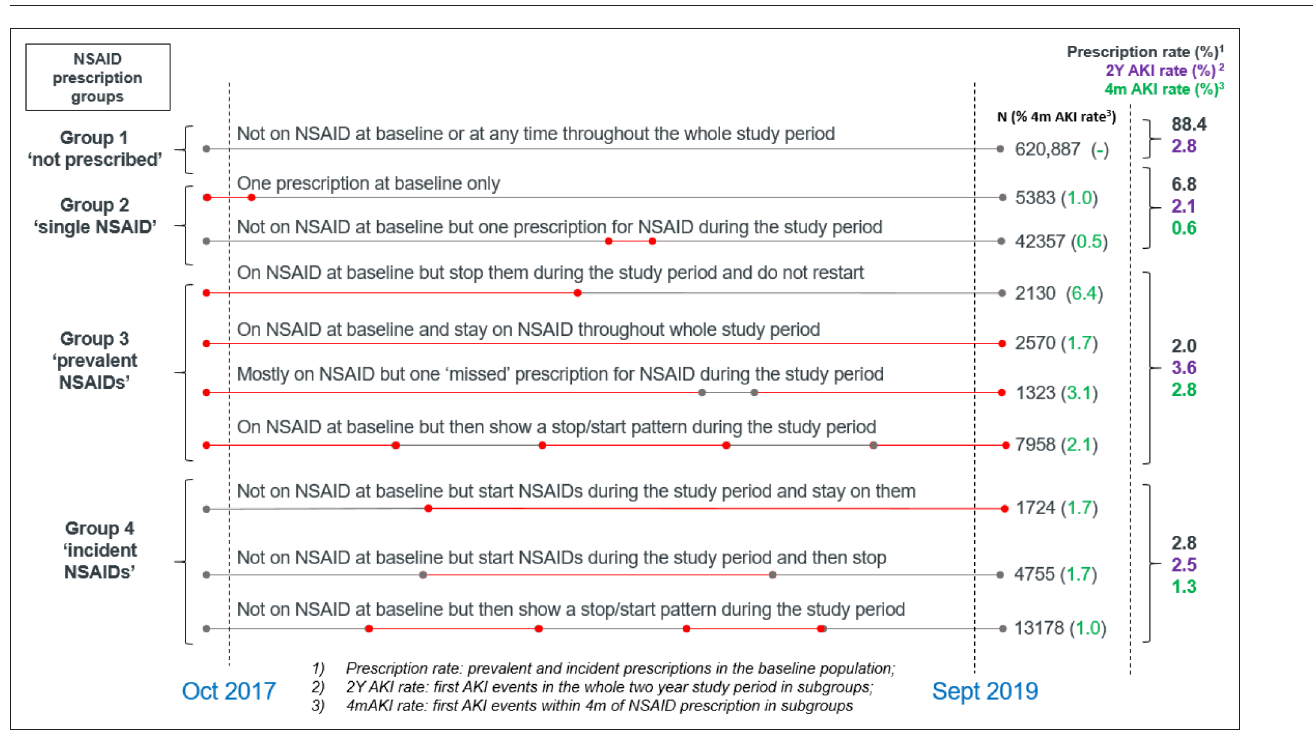
Figure 3 Non- steroidal anti- inflammatory drug (NSAID) prescription patterns throughout the study period. AKI = acute kidney injury. M = month. Y =